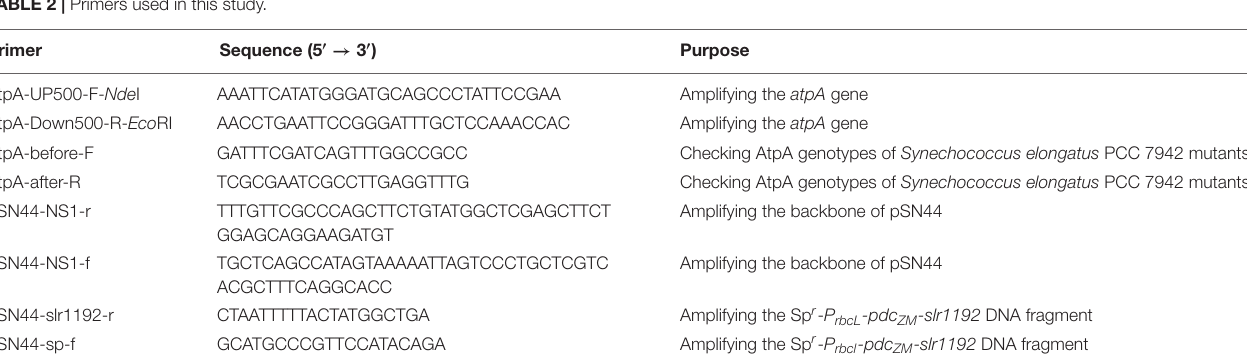
TABLE 2 | Primers used in this